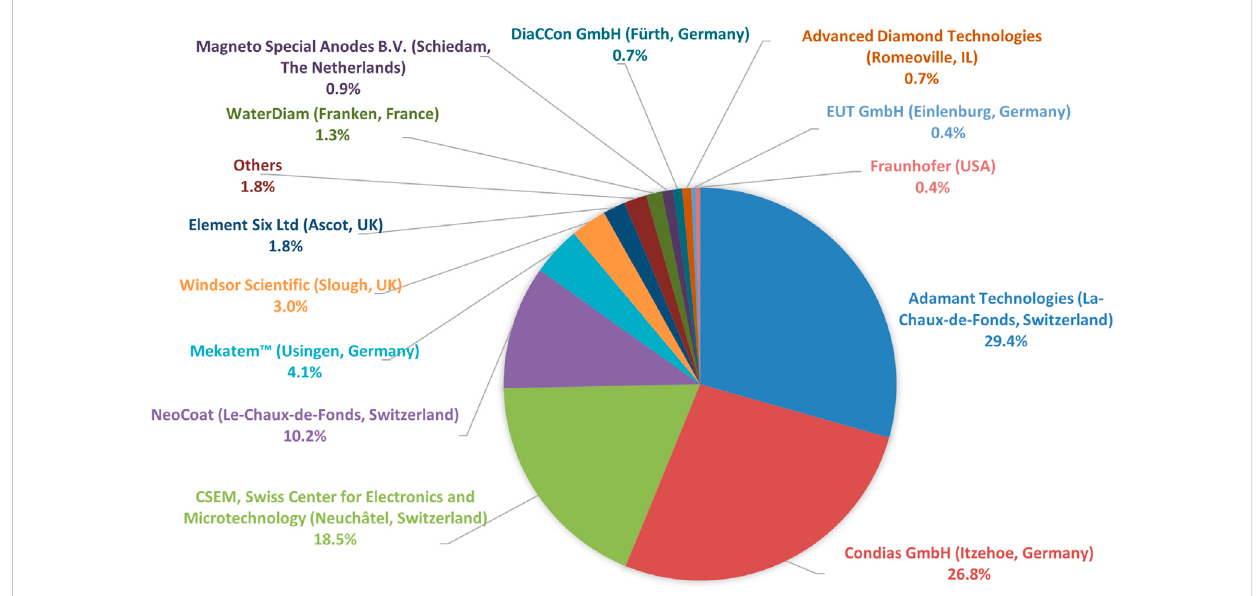
FIGURE 6 Commercial BDD manufacturer preference based on the bibliometric analysis search (source: the authors).